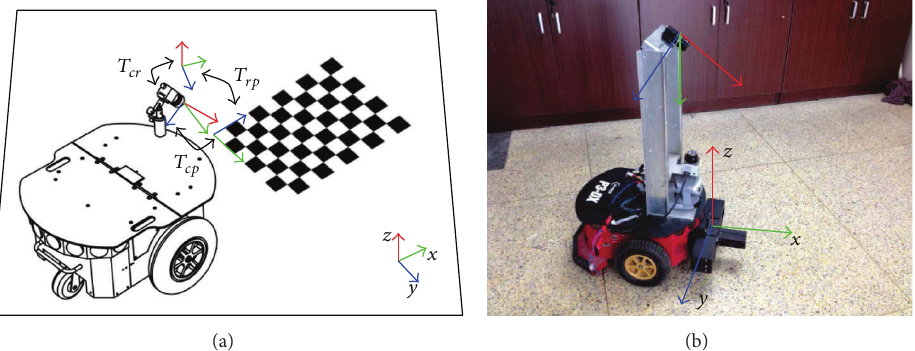
Figure 2: The parameter calibration for mobile robot: (a) is the procedure of calibration of plane parameter, and (b) is the robot platform.